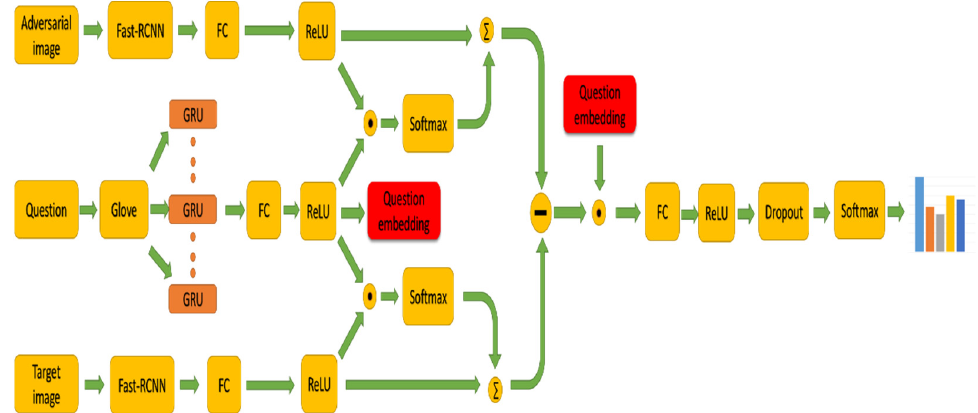
Figure 2. Overview of the proposed model. The target image–question pair and the adversarial image–question pair perform feature extraction and feature fusion operations respectively and then predict the correct answer through the classification network.